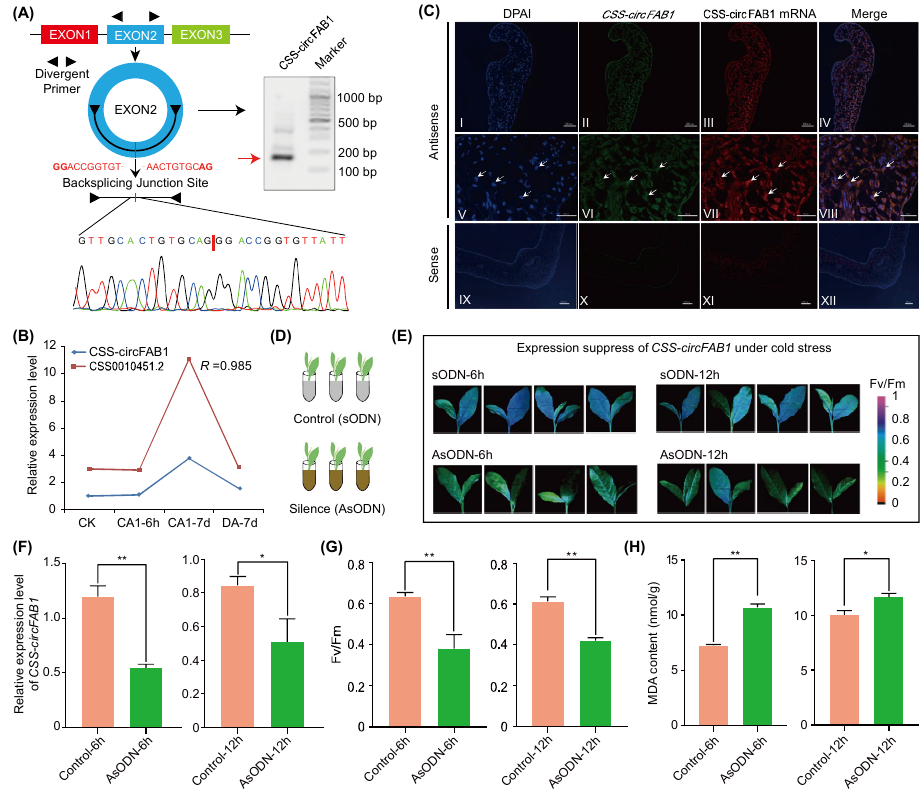
Figure 4. Circular RNA CSS-circFAB1 contributes to tea plant cold tolerance. ( A ) Validation of CSS- circFAB1 sequences by PCR and Sanger sequencing. ( B ) Relative expression levels of CSS-circFAB1 and CSS0010451.2 genes under cold acclimation revealed by qRT-PCR and their expression correla- tion. ( C ) FISH experiment of CSS-circFAB1 in tea plant leaves (I, II, V, and VI). The FISH of CSS- circFAB1 mRNAs is shown for comparison (III, VII). IX-XII: Control sense probes. Scale bars = 100 μm (I–IV and IX–XII); 50 μm (V–VIII). ( D ) A schematic diagram of antisense oligodeoxynucleotides- based gene silencing of CSS-circFAB1 . ( E ) Determination of the net photosynthetic rate and the max- imum photochemical efficiency of photosystem II ( Fv/Fm ) of CSS-circFAB1 silenced (6 h and 12 h) and control tea plants. ( F ) Relative expression levels of CSS-circFAB1 feeding with AsODN at 6 h and 12 h compared to control. ( G ) Fv / Fm values in CSS-circFAB1 silenced and control tea plants. ( H ) MDA content of CSS-circFAB1 silenced samples compared to control. * p value < 0.05; ** p value < 0.01. 3. Discussion Circular RNAs are covalently closed single-stranded non-coding RNAs that are widespread in eukaryotic species [34]. Many studies have revealed that circRNAs have various functional roles, including regulating gene expressions, and binding miRNAs or proteins, involved in individual growth and development, as well as many other biologi- cal processes [17,23,27,35]. However, it is still unclear how circRNA evolves and evolu- tionary characteristics of circRNAs and how circRNA regulates the chilling tolerance in tea plants. In this study, we systemically identified the circRNAs of tea plant and charac- terized their expression patterns under chilling stress. In total, 2702 high-confidence circR- NAs were identified. PCR amplification and Sanger sequencing further revealed that six- teen of the 25 randomly selected circRNAs were successfully validated, indicating an ac- curacy of 64% of circRNA identification in the present study. The accuracy is comparable to those found in many flowering plants (average of 56%) [17,24]. It should be noticed that while the accuracy of circRNA identification is acceptable in the study, its bioinformatics